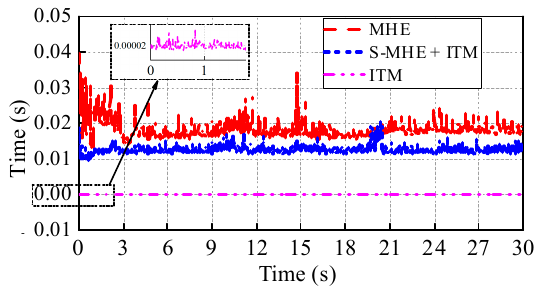
Figure 24. The computation time.